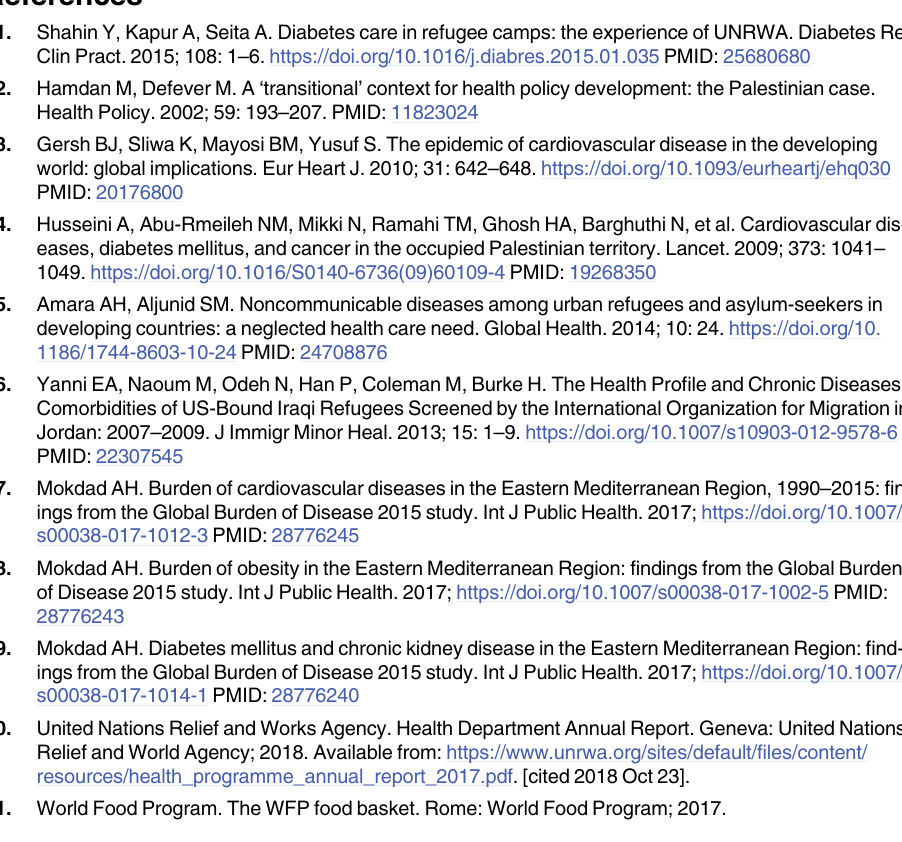
S8 Table. RECODe equation coefficients. S9 Table. CHEERS checklist for the cost-effectiveness analysis. S1 Fig. Covariance between key demographic, dietary, and health